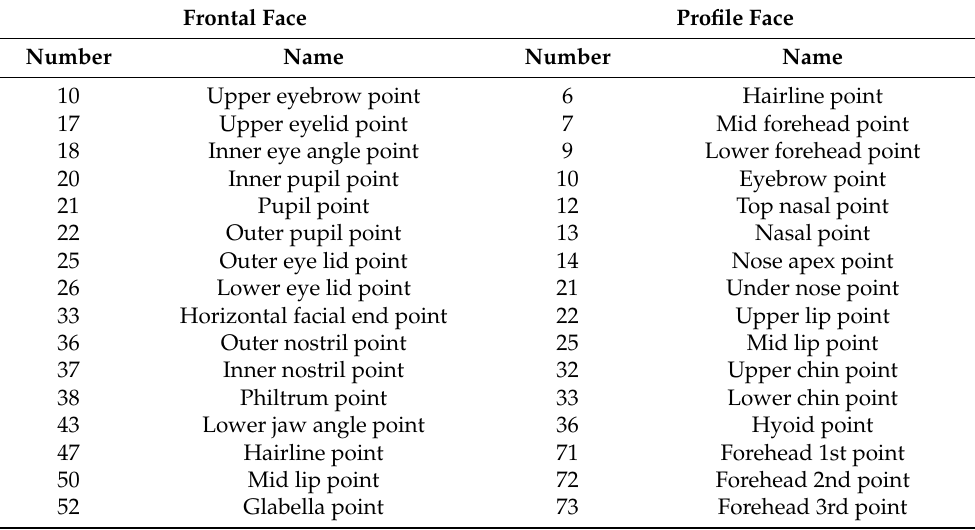
Figure 1. Facial features’ landmarks and facial color areas used for analysis. Table 1. Desciptions of facial feature landmarks.